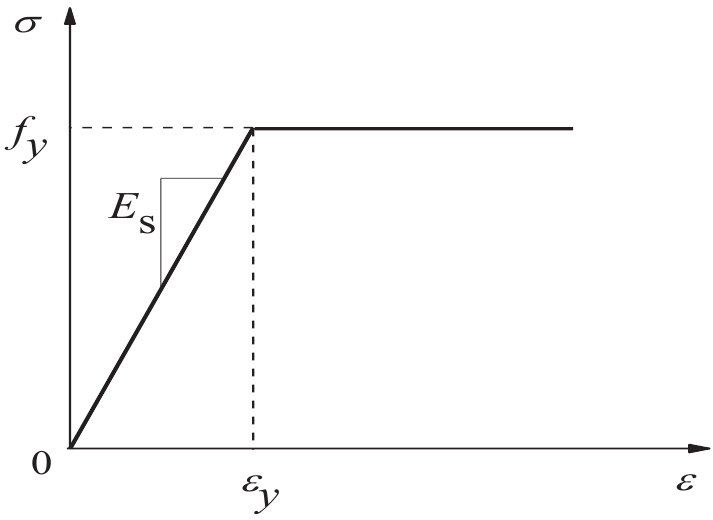
Figure 9. Steel stress–strain relation curve.